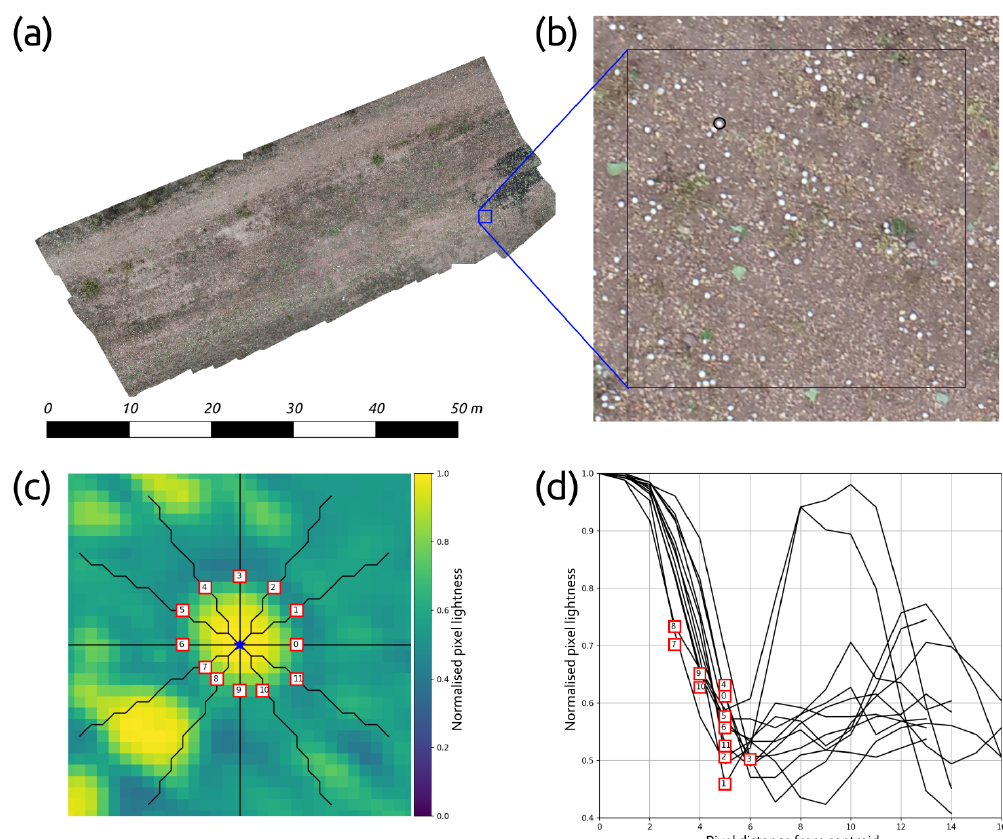
Figure 2. Demonstration of hail size extraction from the 26 November 2018 survey orthomosaic (a) from a single tile ( b : blue bounding box) for a single hailstone ( c : black circle in b ). Radial transects for extracting imagery lightness are shown in (c) as black lines radiating from hailstone centroid (blue marker), and hailstone edge pixels along transects are numbered. The subplot in panel (d) shows the normalized pixel lightness along the 12 transects shown in (c) with the corresponding edge pixels marked.